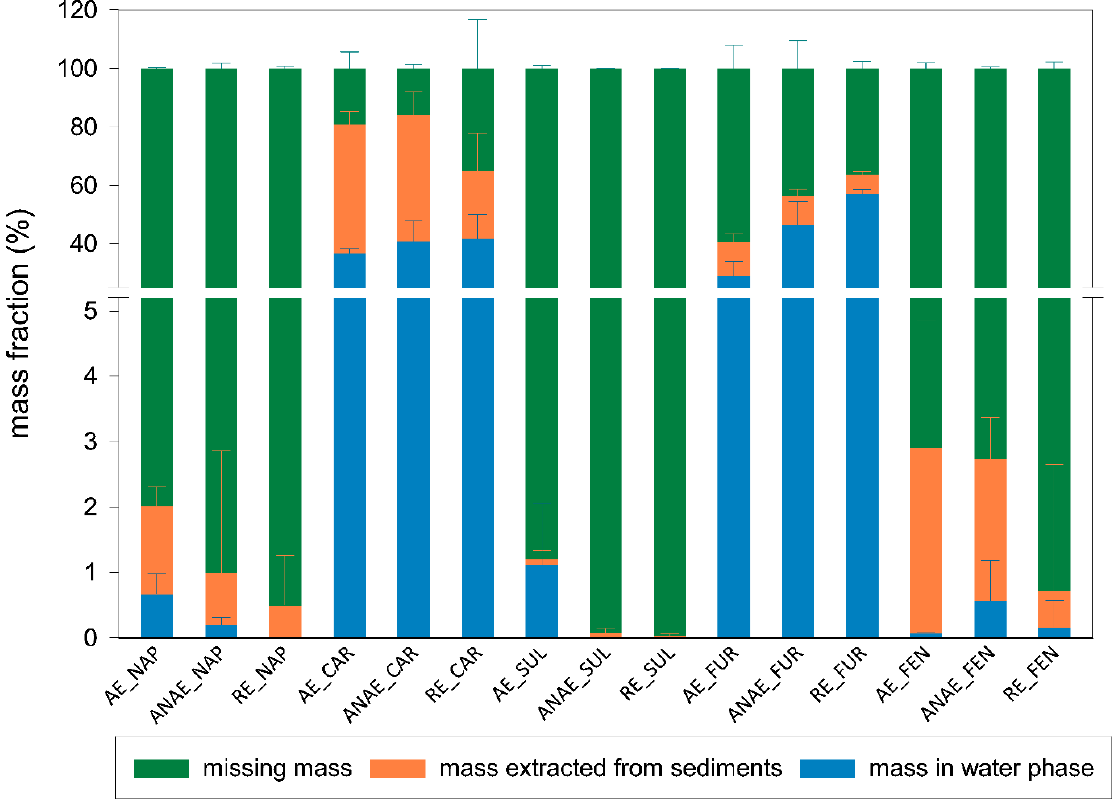
Figure 5. Mass balance in the microcosms at the termination of the experiment. Note the change in axis scale.